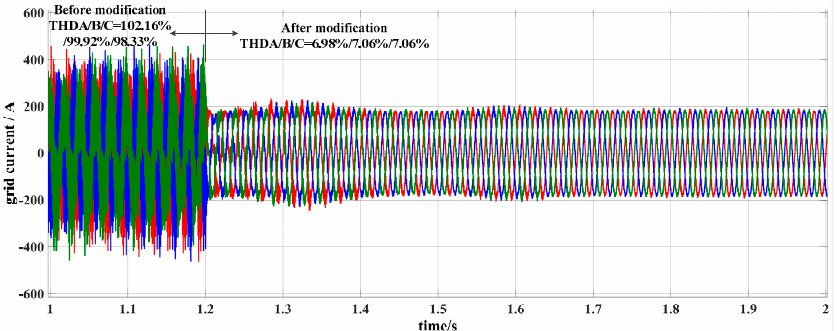
Figure 19. Simulated grid current i sys when shunt APF is compensating for RLC load and rectifier load.